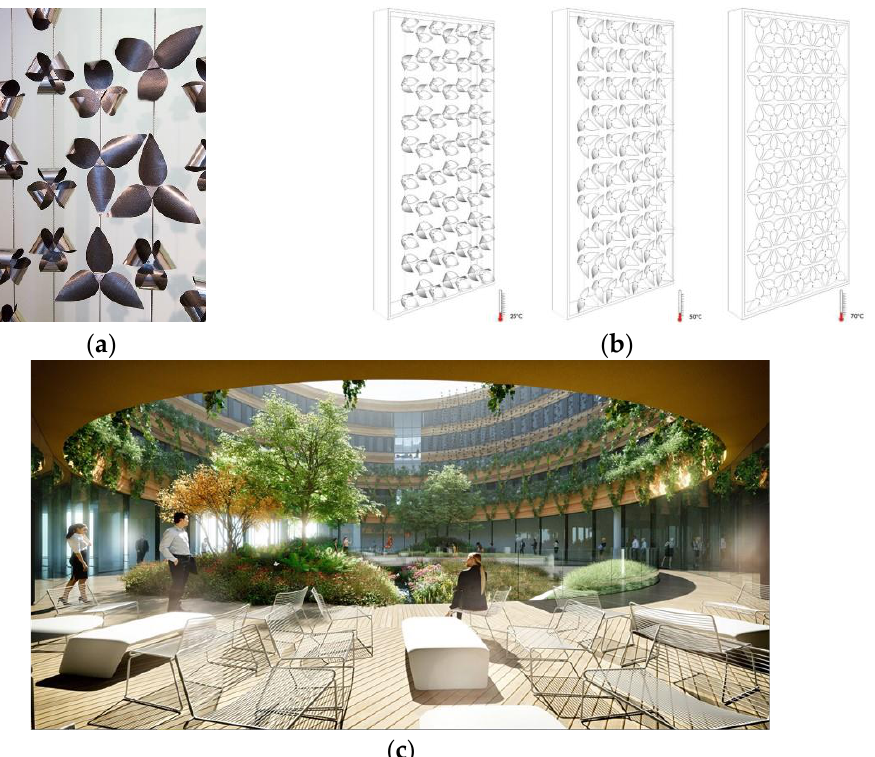
Figure 5. Pho’liage ® inspired by nyctinasty: ( a ) Prototype of Pho’liage autonomous shading device; ( b ) Simulation test of the shading device according to temperature change; ( c ) Simulated model of the shading device envisaged to be implemented at IARC. Reprinted with permission. 2019 © ArtBuild Paris.